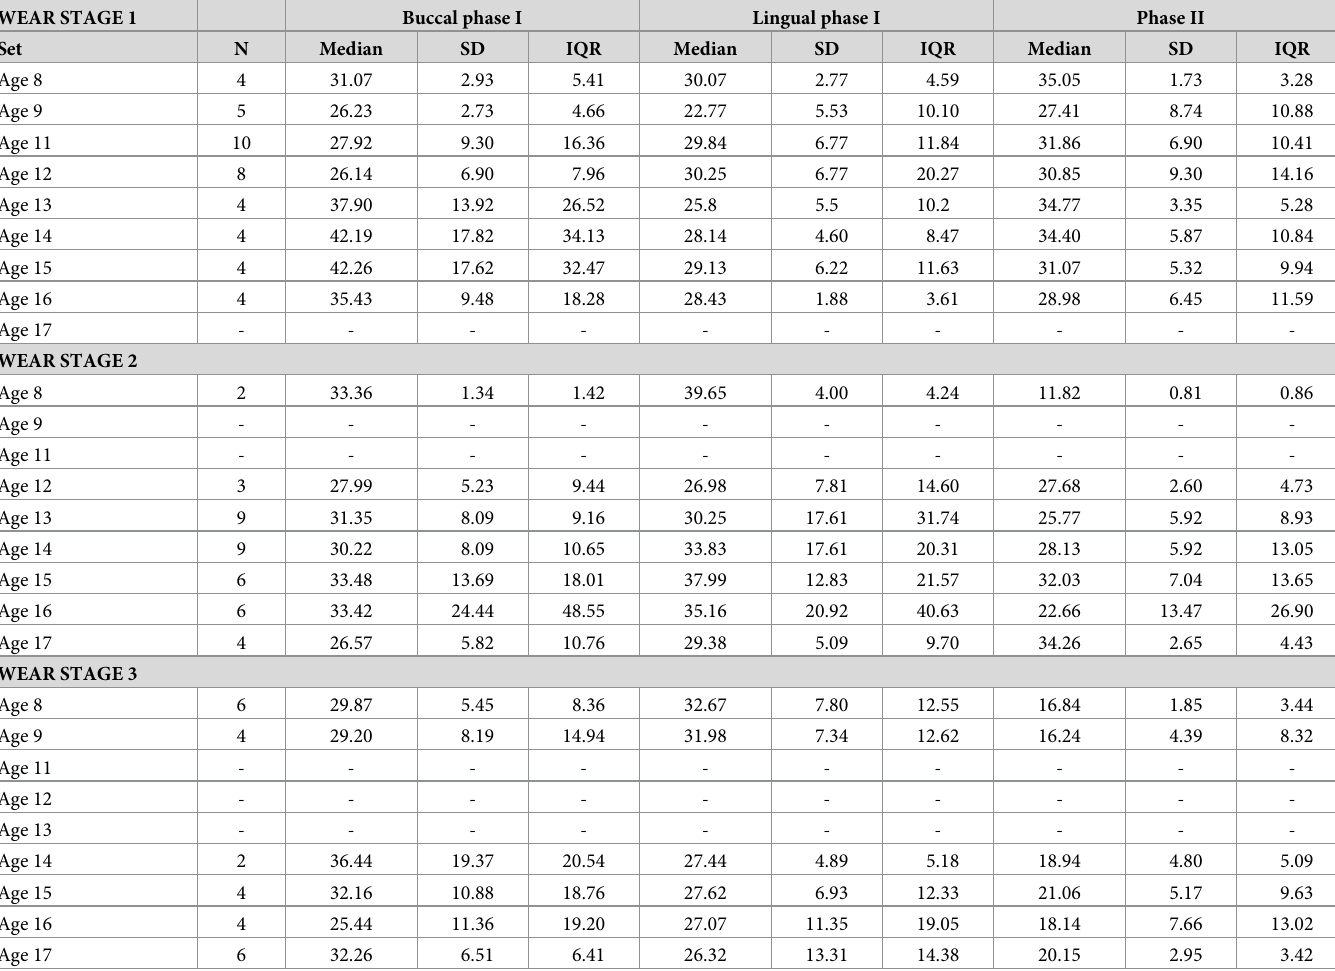
Table 3. Descriptive statistical analysis of wear contact inclinations of posterior teeth grouped according to their wear stage [34], including sample number (N), median, standard deviation (SD) and interquartile range (IQR). WEAR STAGE